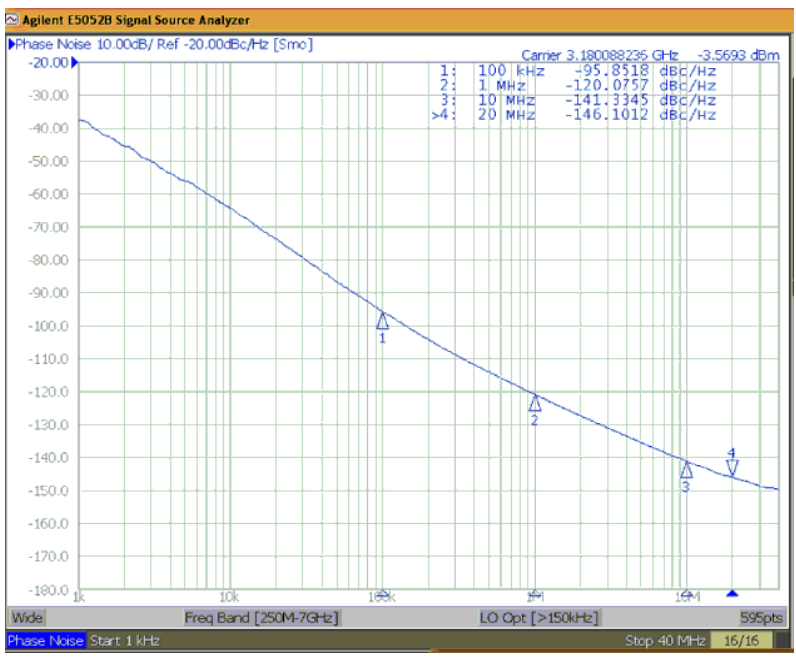
Figure 8. Test results of VCO output.